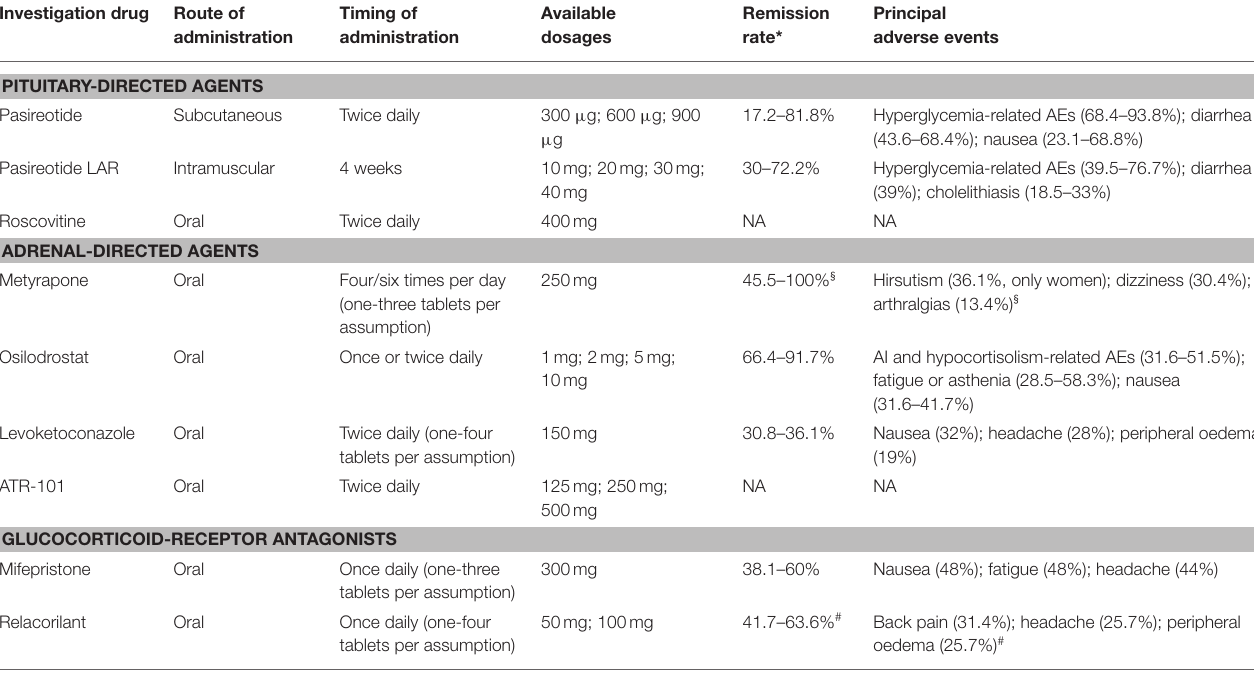
TABLE 1 | Summary of the available data regarding drugs evaluated in recent clinical trials or under investigation, registered in clinicaltrials.gov, in Cushing’s disease and Cushing’s syndrome in terms of administration route and timing, available dosages, remission rate, and safety profile. Investigation drug Route of Timing of administration